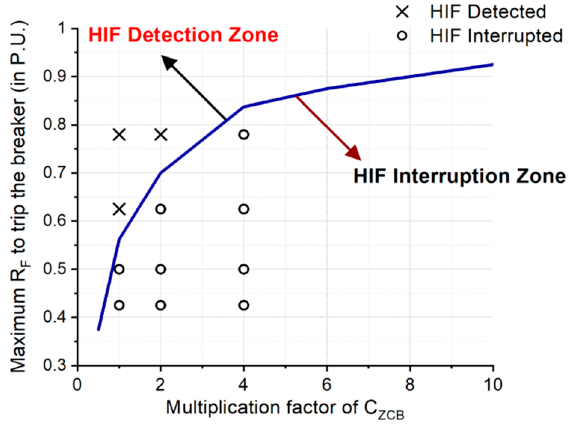
Figure 13. A zoomed-in effective region of Figure 3, with specified HIF conditions.